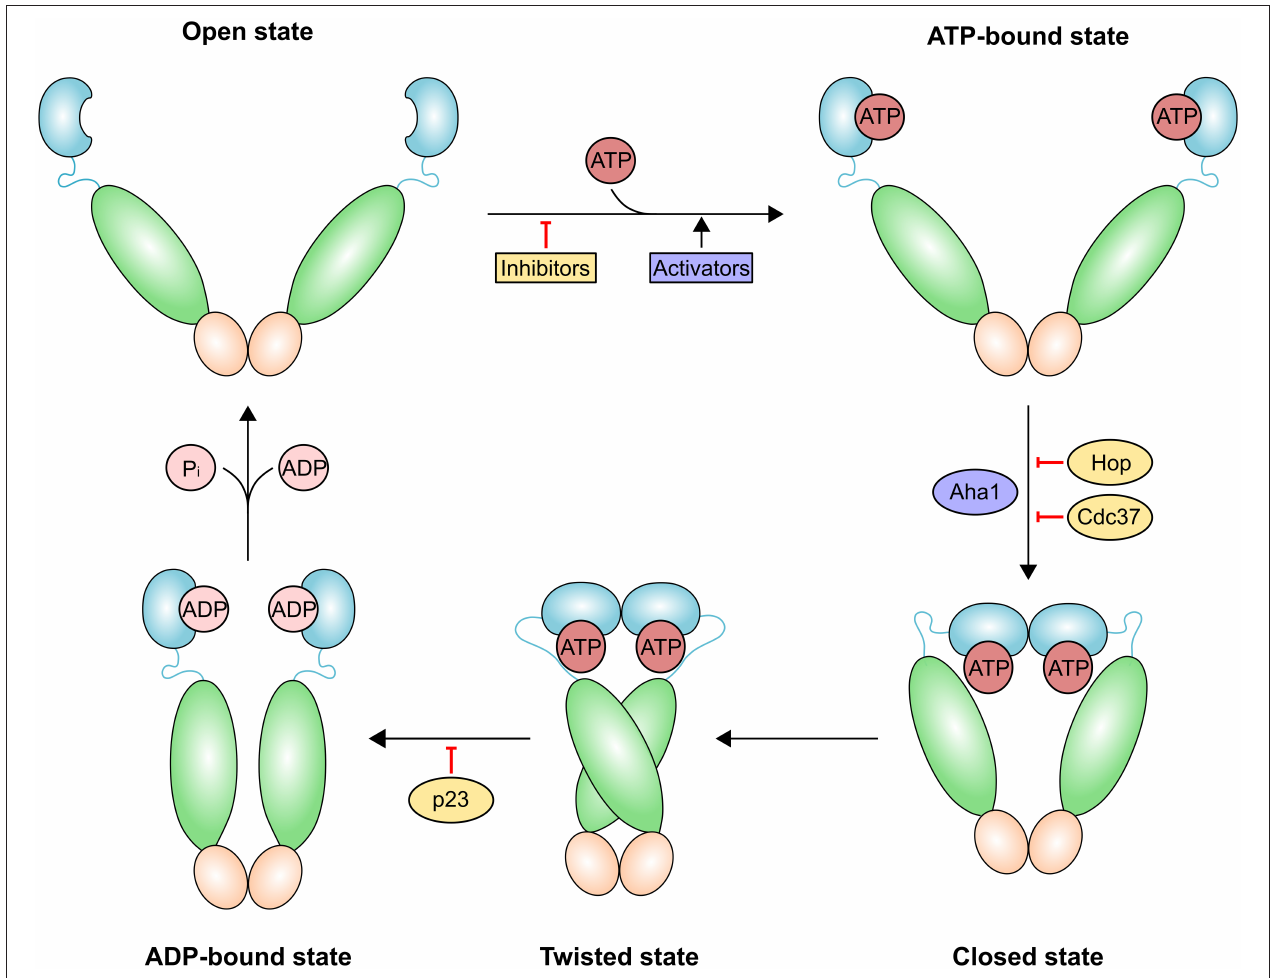
FIGURE 2 | Schematic representation of the HSP90 conformational cycle. HSP90 domains are shown in different hues and colored blue [ATP-bound, ADP-bound or naked N-terminal domain (NTD)], green [middle domain (MD)] and orange [C-terminal domain (CTD)]. Binding of the co-chaperone activator of Hsp90 ATPase homolog 1 (AHA1) or allosteric HSP90 activators promote the formation of the closed state and increase the rate of ATP hydrolysis. The co-chaperones HOP (also known as STIP1) and cell division cycle 37 homolog (CDC37) and HSP90 inhibitors exert an opposite effect by preventing the structural changes necessary for the completion of the cycle. Prostaglandin E synthase 3 (p23; also known as PTGES3) slows the HSP90 ATPase cycle by stabilizing the twisted